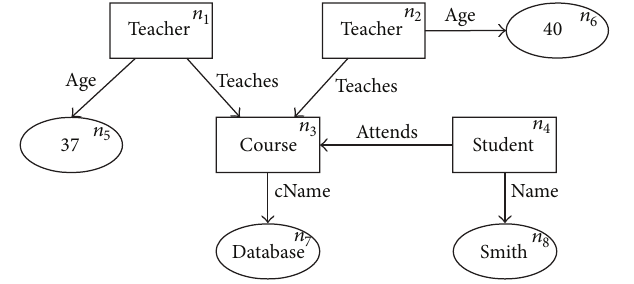
Figure 1: A W-instance 𝐼